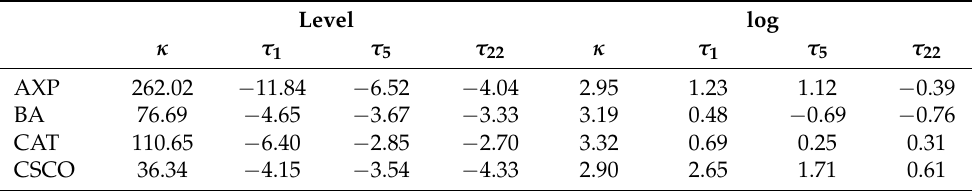
Table A3. Estimates of interaction term in HARQ models. ‘level’ is HARQ with y = RV , q = and ‘log’ is with y = ln ( RV ) , q = ln ( RQ ) . κ is the sample kurtosis of y where κ = 3 for a Gaussian. τ h are the HAR t -ratios for the interaction term q t − 1 y t − 1 for forecast step size h days. The daily sample is from 22 April 1997 to 31 December 2013 (4200 trading